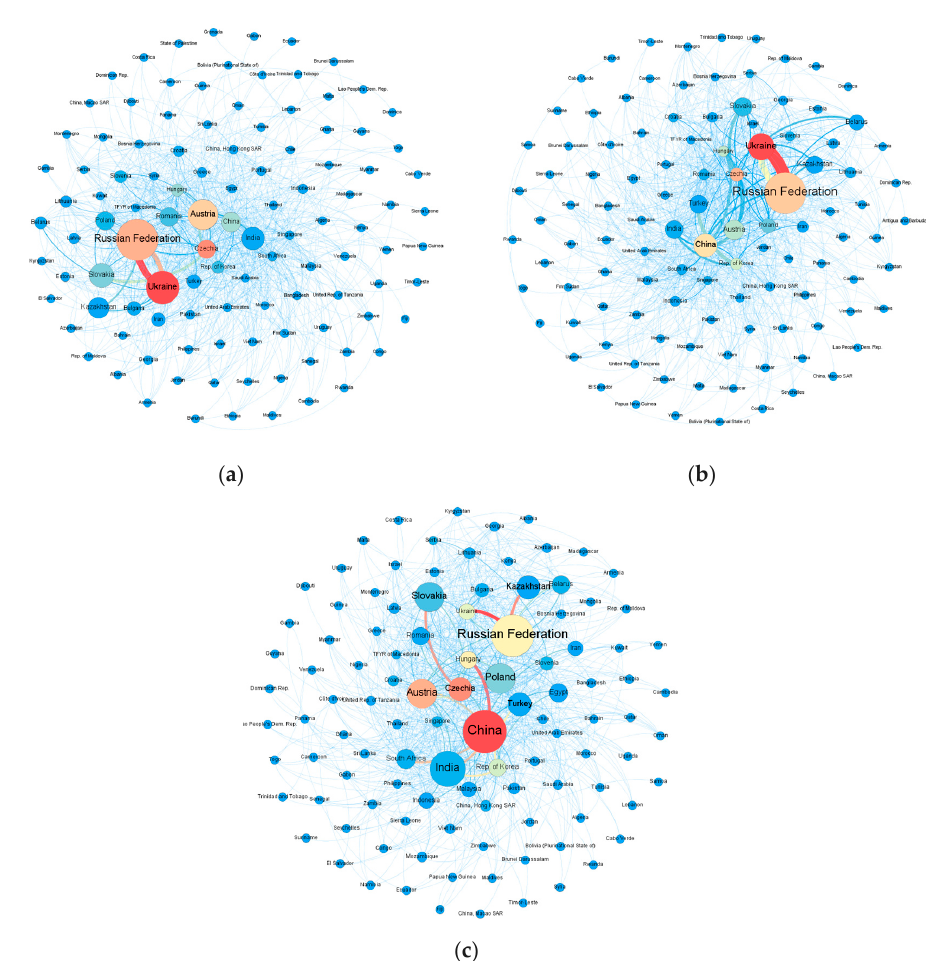
Figure 8. Trade networks of parts products in the BRI region. ( a ) phase 1 (2003–2008), ( b ) phase 2 (2009–2013), ( c ) phase 3 (2014–2017). The settings are the same as in Figure 7.